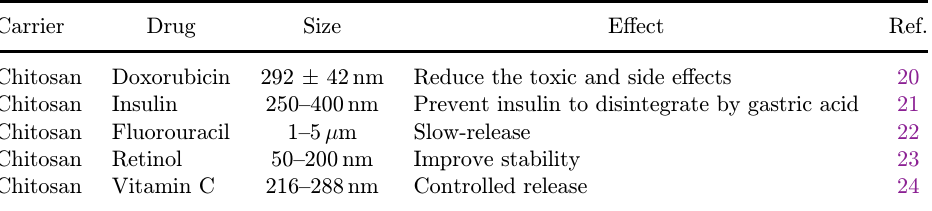
Table 1. Summary of chitosan microsphere for Bio-applications.